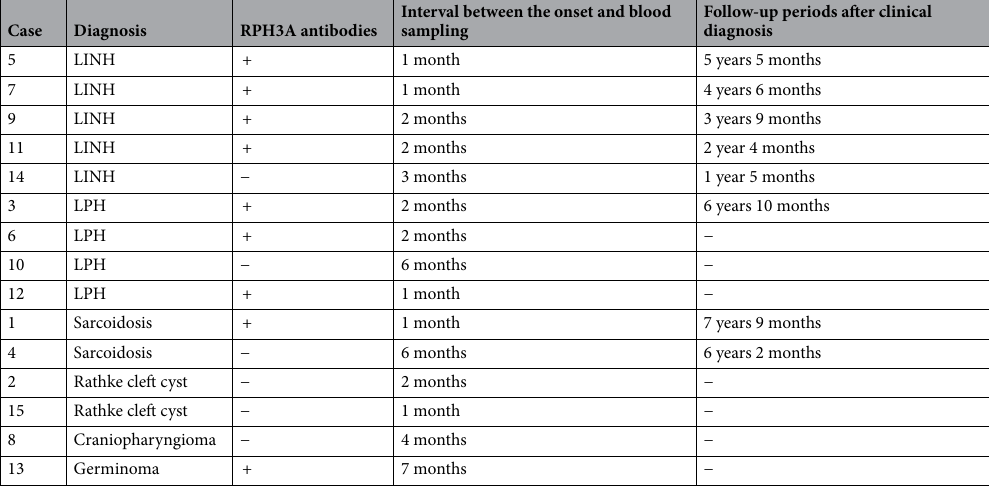
Table 2. Clinical/histopathological diagnosis, presence of anti-rabphilin-3A (RPH3A) antibodies, and the interval between onset and blood sampling in 15 patients with central diabetes insipidus. The follow-up period (last diagnosis) is provided for the patients who were diagnosed clinically without histopathological examination.